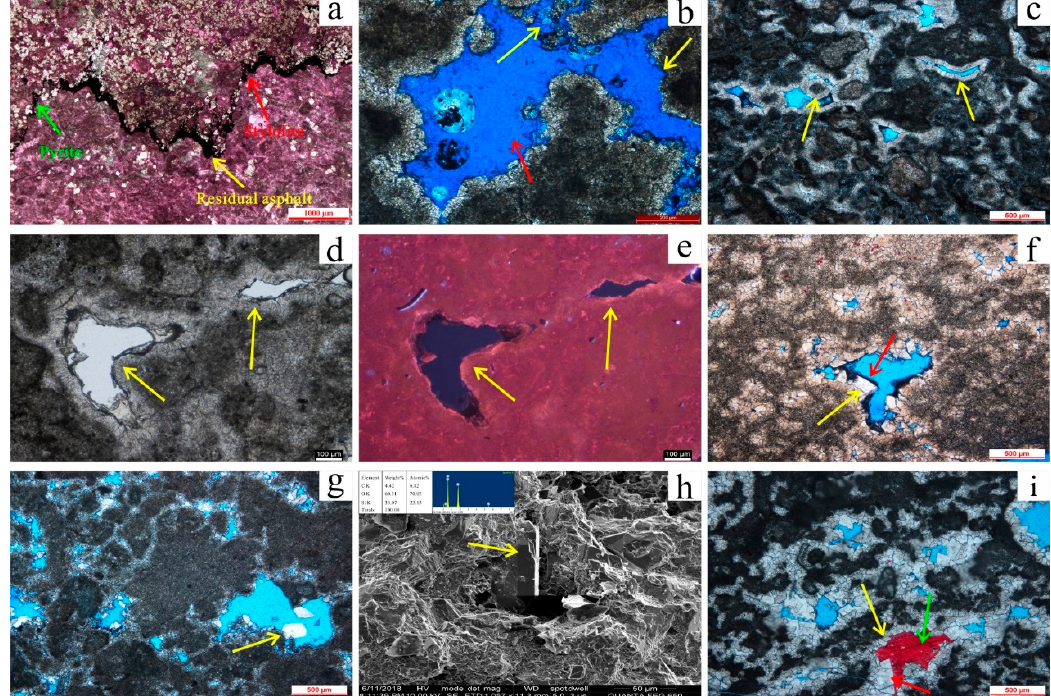
Figure 10. Microscopic characteristics of the diagenesis in the Leikoupo Formation. ( a ) Residual asphalt (yellow arrow) and pyrite (green arrow) in stylolite (red arrow), T 2 l 43 , Yangshen-1 well, 6170.51 m; ( b ) Expansion dissolution (yellow arrow) on the basis of early dissolution pores (red arrow), T 2 l 43 , Anfu-1 well, 5702.97 m; ( c ) Isopachous and circumgranular dolomite (yellow arrow), T 2 l 43 , Yangshen-1 well, 6229.50 m; ( d ) Isopachous and circumgranular dolomite (yellow arrow), T 2 l 43 , Yangshen-1 well, 6229.50 m; ( e ) Analysis of isopachous and circumgranular dolomite (yellow arrow) in cathodoluminescence, T 2 l 43 , Yangshen-1 well, 6229.50 m; ( f ) Euhedral dolomite (yellow arrow) and residual asphalt (red arrow) around it, T 2 l 43 , Yashen-1 well, 5782.60 m; ( g ) Single quartz crystal (yellow arrow), T 2 l 43 , Yangshen-1 well, 6229.90 m; ( h ) Single quartz crystal in SEM (yellow arrow), T 2 l 43 , Yangshen-1 well, 6229.90 m; ( i ) Dog-tooth dolomite (yellow arrow), euhedral dolomite (red arrow), and calcite (green arrow), T 2 l 42 , Yangshen-1 well, 6224.70 m.